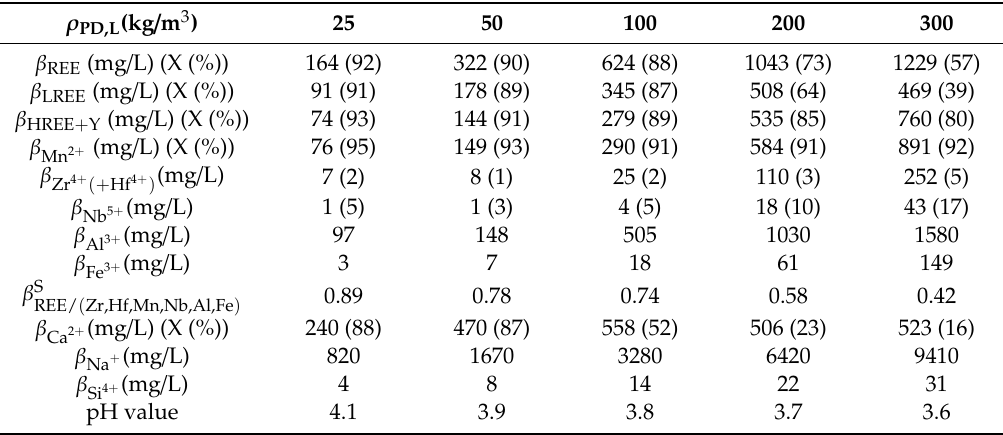
Table 2. Effect of pulp density on concentrations and leaching yields (X) of REEs, LREEs, HREEs + Y, Mn 2+ , Zr 4+ (+Hf 4+ ), Nb 5+ , Al 3+ , Fe 3+ , Ca 2+ , Na + and Si 4+ , on separation factor and pH value of the leach solution ( (cid:1866) (cid:2892) (cid:3126) /(cid:1865) (cid:2913)(cid:2925)(cid:2924)(cid:2913). = 15 mmol/g; T G = 750 °C; t G = 2 h; ϱ PD,L = 25 kg/m 3 ; T L = 20 °C; t L = 24 h; r R,L = 300 rpm).